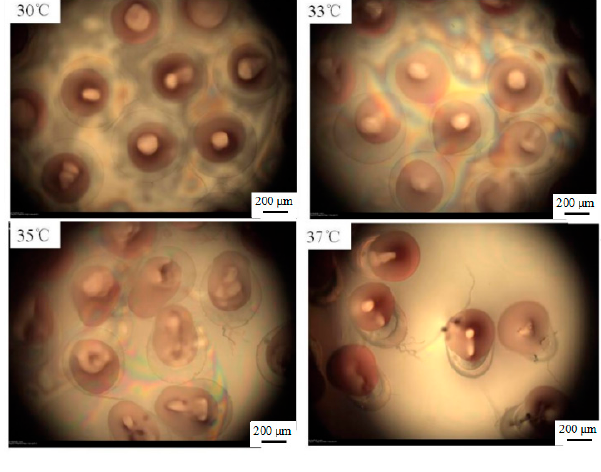
Figure 5. Optical microscopy photographs of P(NIPA- co -MAA) microcapsules in deionized water at 20 °C. The MAA content is 3 mol.%.